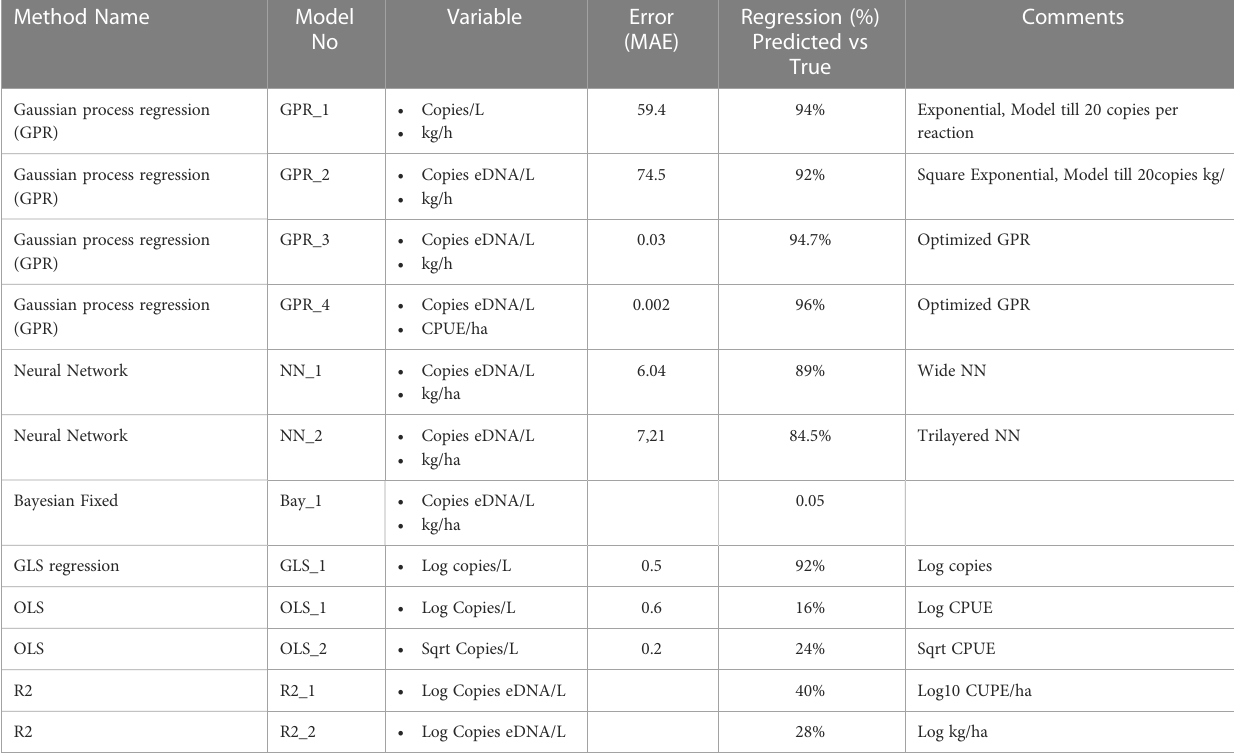
TABLE 5 Modeling results with tests for various combinations of covariates on cod eDNA concentrations at fi shing positions where eDNA levels were above the level of quanti fi